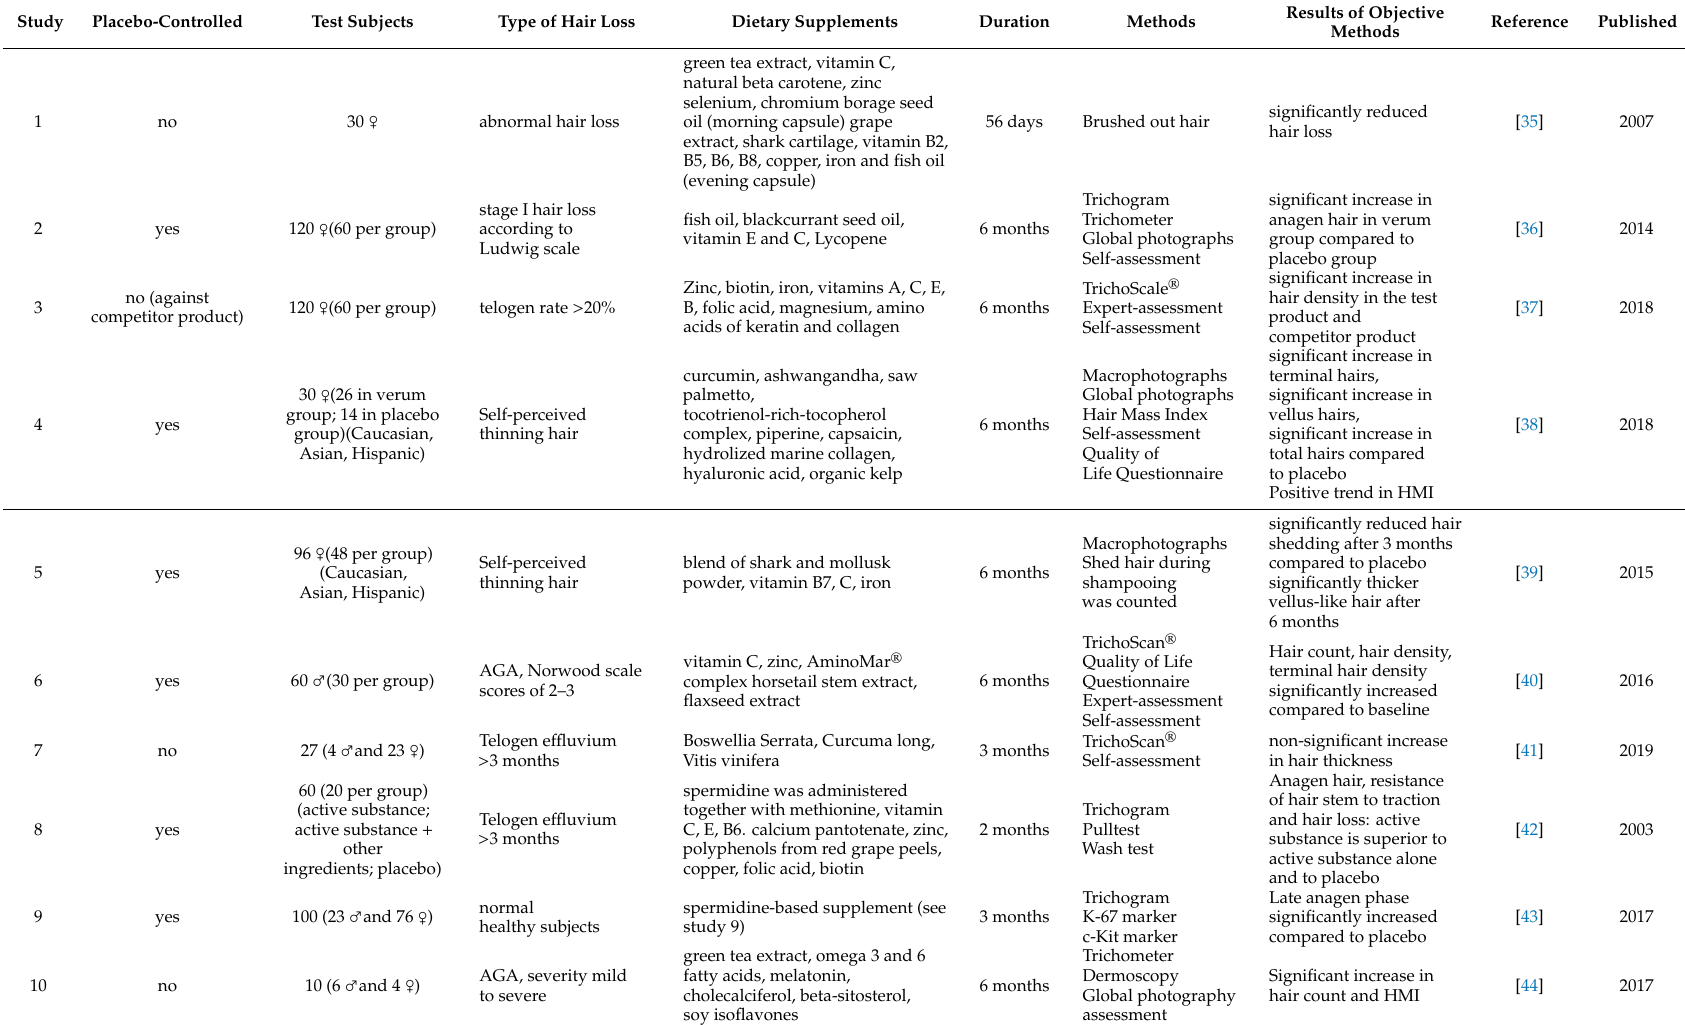
Table 1. Overview of complex dietary oral supplement